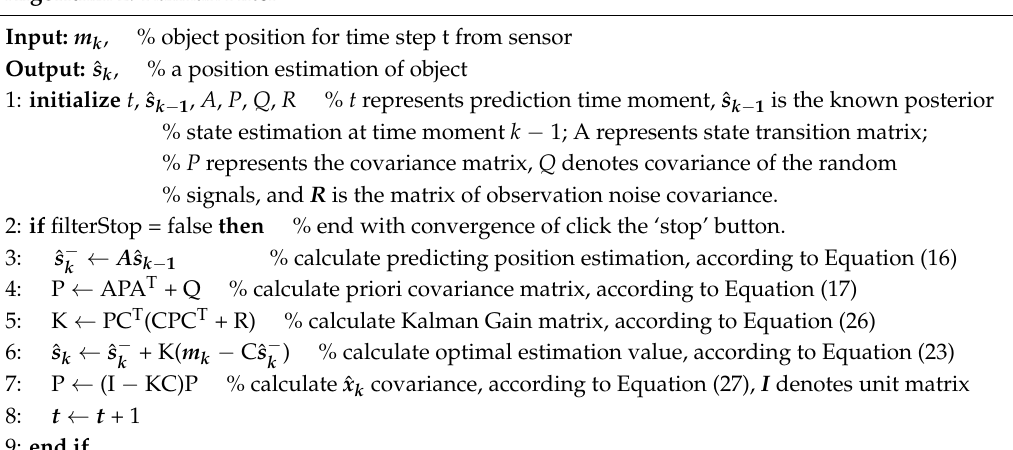
Algorithm 2. Kalman